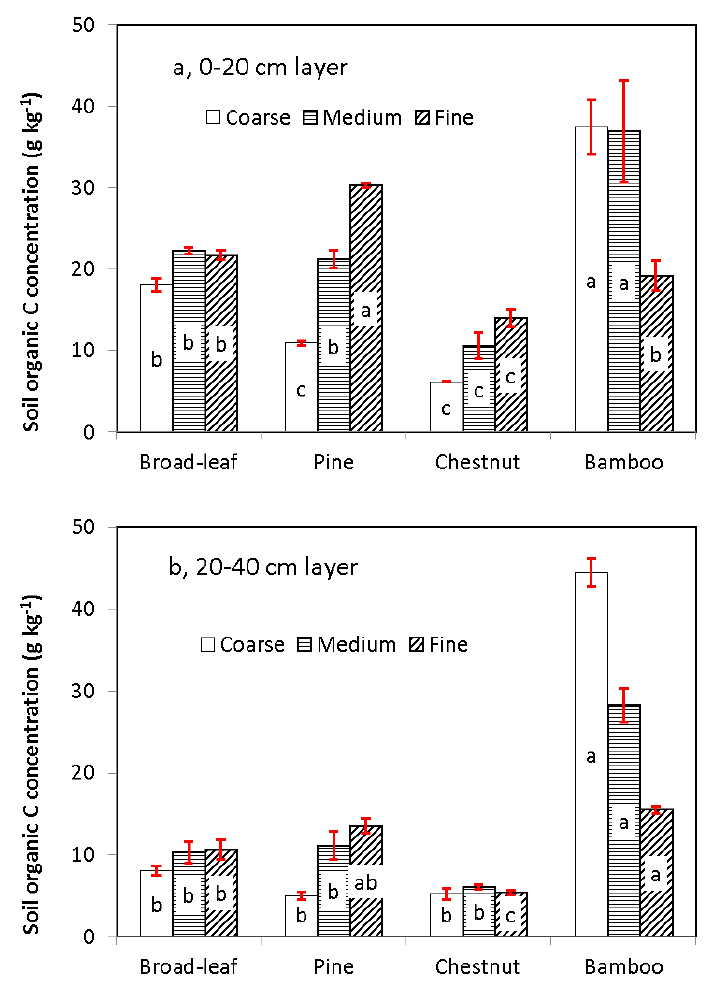
Figure 1. Soil organic carbon associated with different particle size fractions in the ( a ) 0–20-cm layer and ( b ) 20–40-cm layer under four types of forest vegetation-land use. Concentrations are per soil fraction mass. Means labeled with different lowercase letters are different between the vegetation-land use types within each particle size fraction. The three size fractions are coarse (>250 μm), medium (250–53 μm) and silt-clay fractions (<53